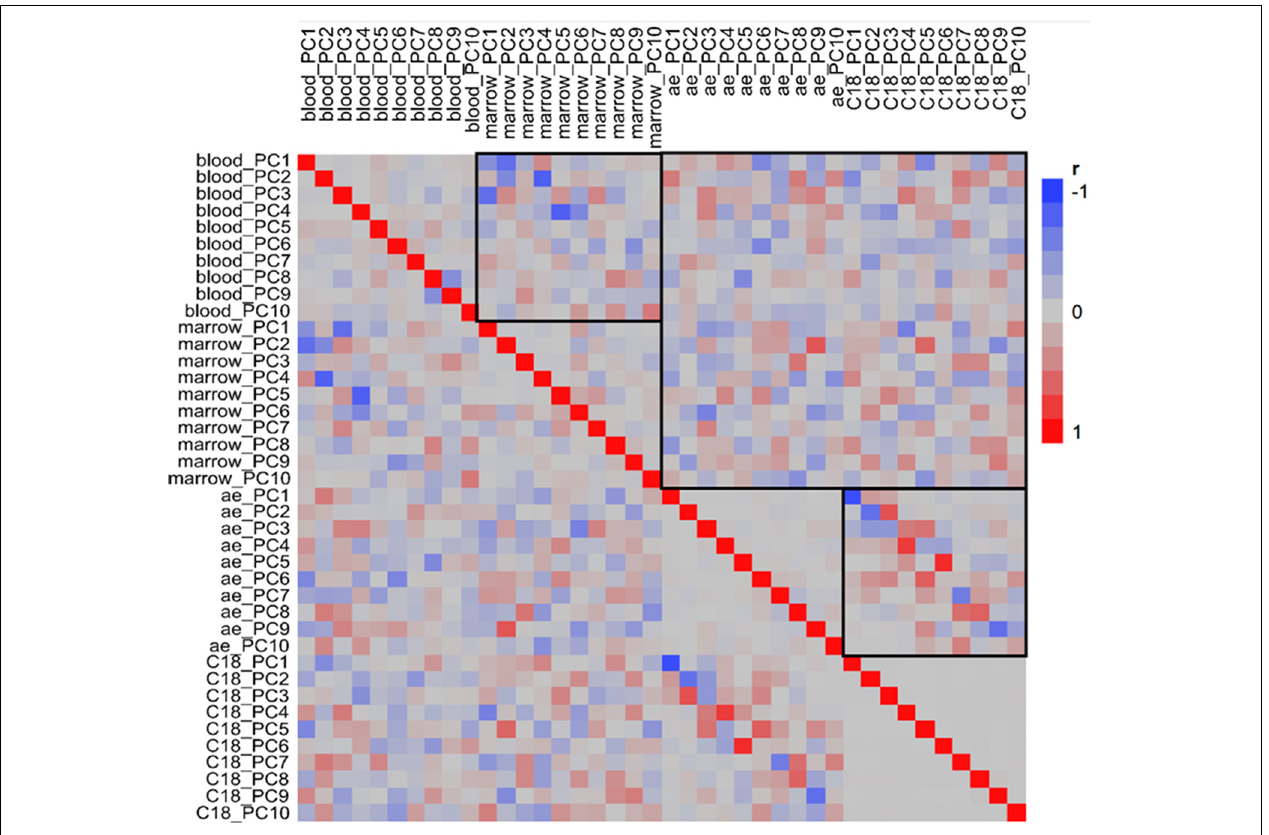
FIGURE 4 | Pairwise correlation of principal components. Heatmap shows correlations of the first 10 principal components for each of the four omic datasets ordered by peripheral blood, bone marrow, AE and C18 (blue negative, red positive, stronger hues indicate stronger correlation). The highlighted boxes in the top left and bottom right quadrants show the